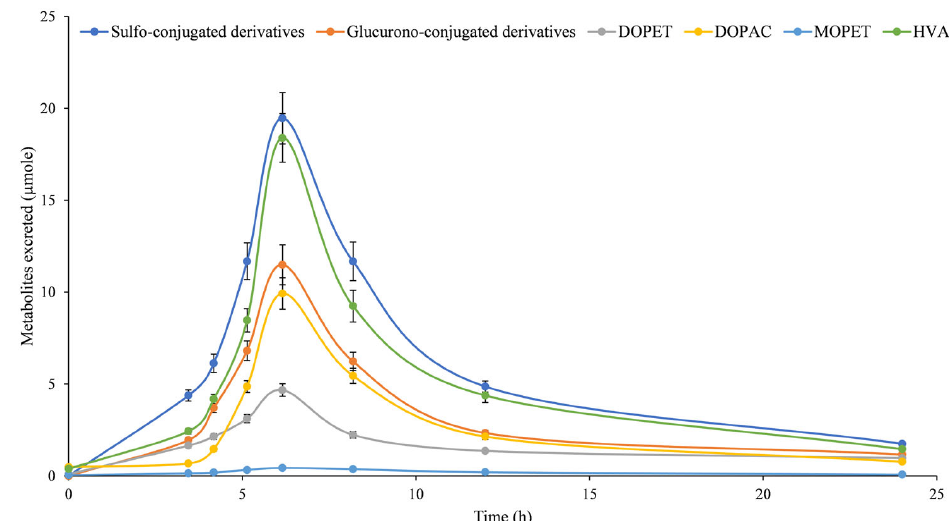
Figure 3. Mean concentration-time profile of metabolites present in urine after an oral dose (15 mg,